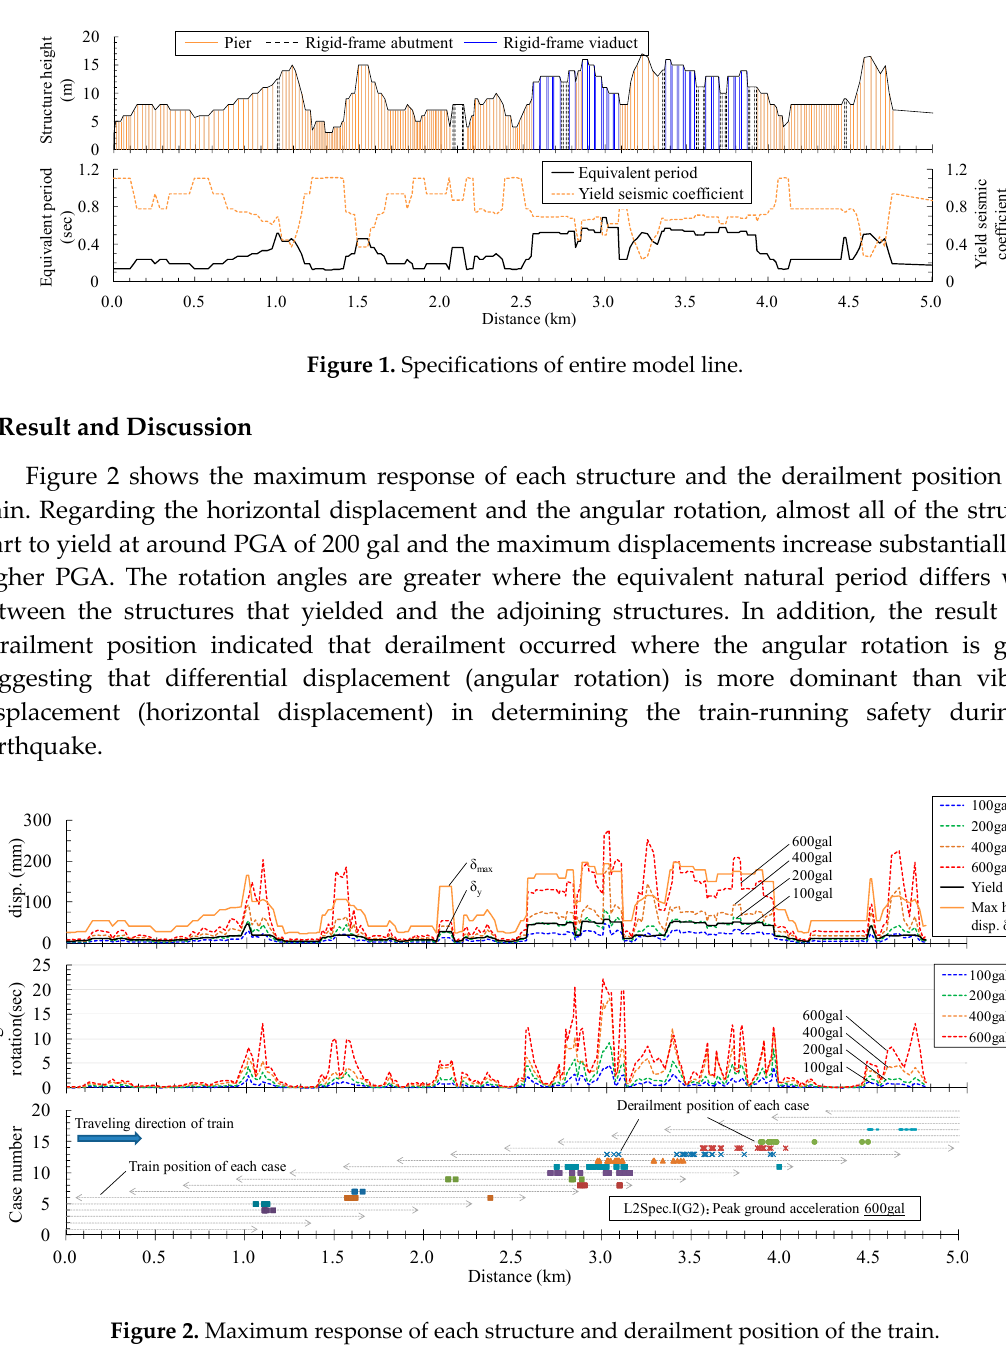
Figure 2. Maximum response of each structure and derailment position of the